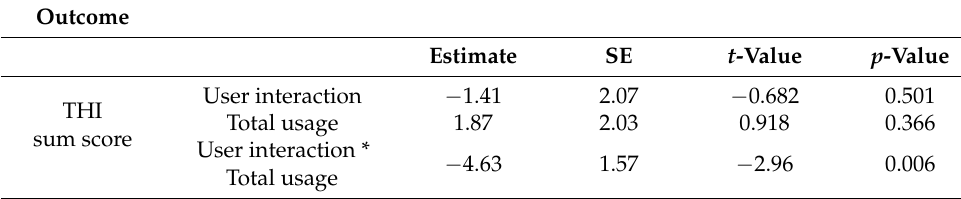
Table 3. User engagement of enrolled participants.